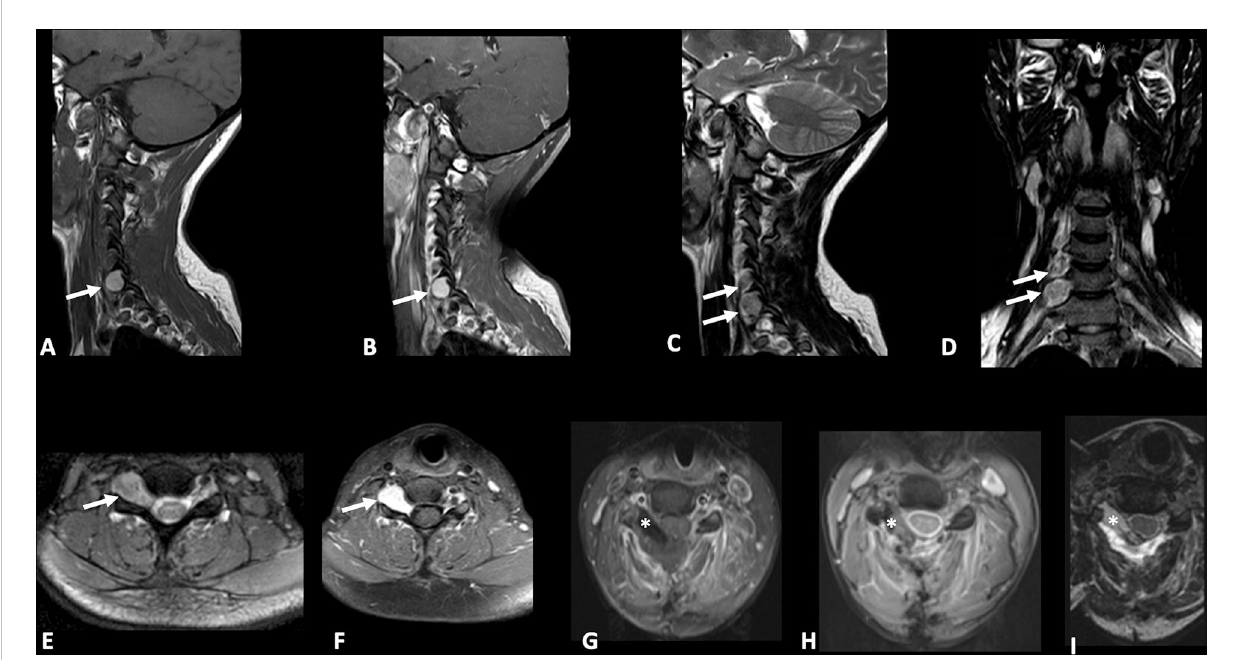
FIGURE 2 Pre-operative sagittal T1-weighted (A) , sagittal (B) and axial (F) post-gadolinium T1-weighted, sagittal (C) , coronal (D) , axial (E) T2-weighted Nuclear Magnetic Resonance (MRI) images demonstrating the presence of two right sided extradural spinal lesions (arrows) at C5-C7 levels one of which is larger with intraforaminal and paravertebral extension and “ dumbbell ” shape. Postoperative axial post-gadolinium T1-weighted and fat suppression (G) , Gradient echo (GRE) (H) , and T2-weighted (I) MRI images demonstrating gross total resection (GTR) of lesions and placement of fat tissue (asterisk) to reinforce dural